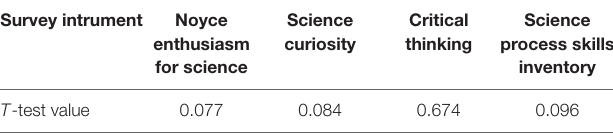
TABLE 5 | Paired t -tests for survey instrument